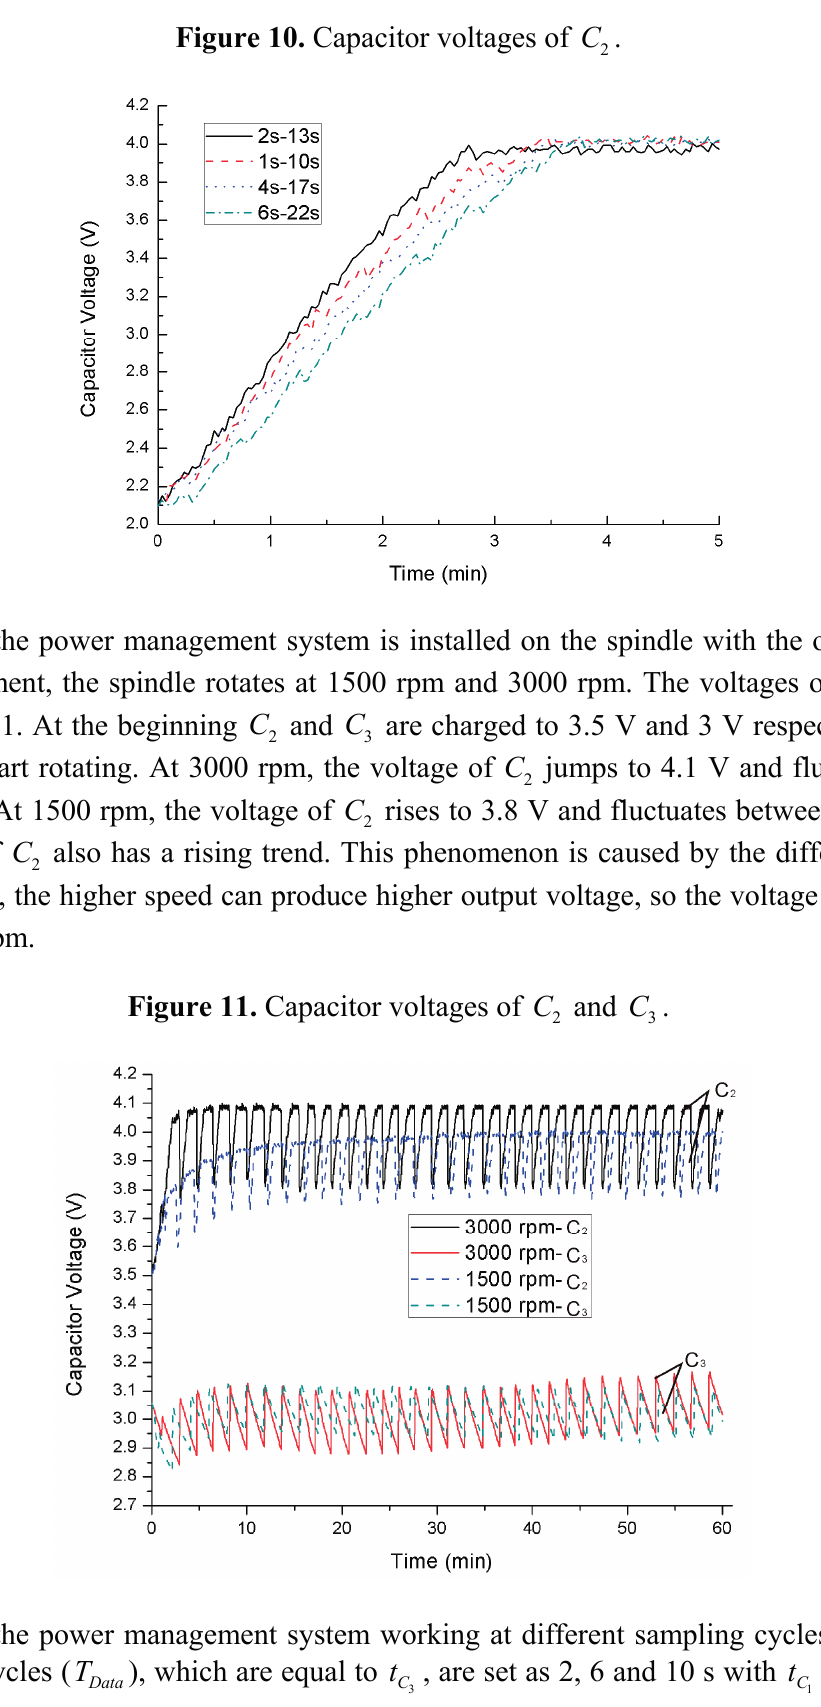
Figure 10. Capacitor voltages of